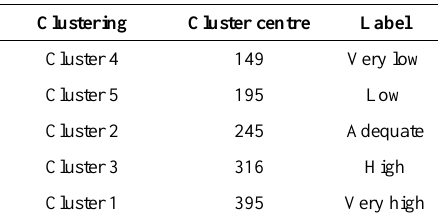
Table 19. Cluster labelling